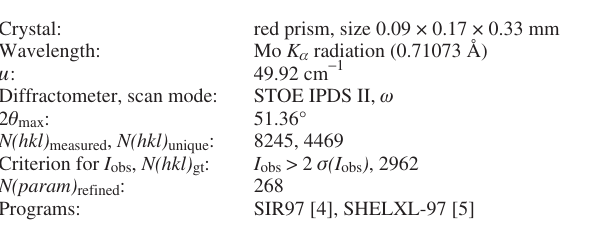
Table 1. Data collection and handling.